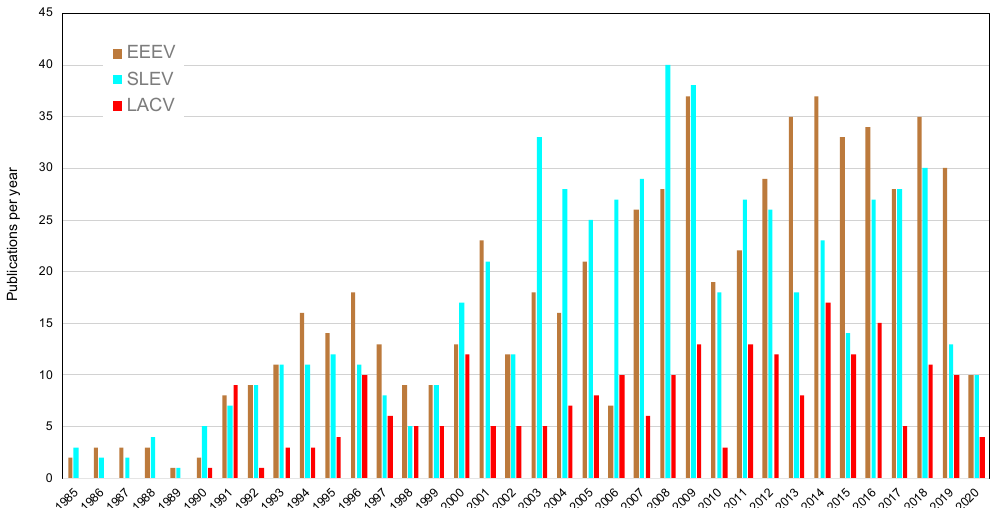
Figure 4. Results of a Basic Search of the Web of Science Core Collection for eastern equine encephalitis virus (EEEV), St. Louis encephalitis virus (SLEV), and La Crosse encephalitis virus (LACV) from